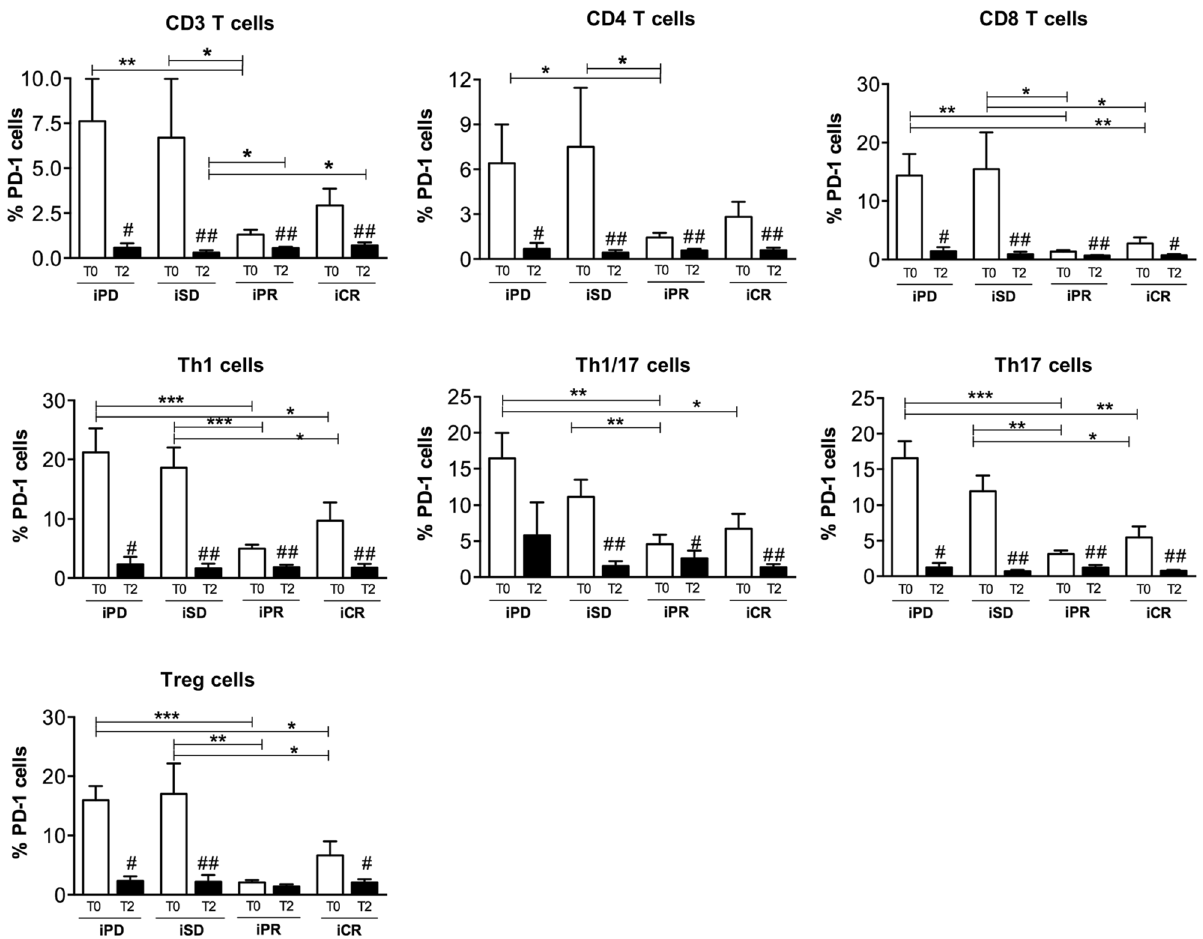
Figure 5. Expression of PD-1 in circulating T lymphocytes of melanoma patients treated with CPIs. Frequency of PD-1 positive cells gated within CD3, CD4, CD8, Th1, Th1/17, Th17, and Treg cells, was analyzed by flow cytometry in PBMCs of melanoma patients before (T0) and after 3 months (T2) of treatment. Best overall response according to iRECIST criteria: iPD, progressive disease (n. 7 patients); iSD, stable disease (n. 8 patients); iPR, partial response (n. 8 patients); complete response, iCR (n. 10 patients). Data are indicated as mean value ± standard error of the mean (SEM). * p < 0.05, ** p < 0.01, *** p < 0.001 as assessed by Mann–Whitney U test to compare between-group differences; # p < 0.05, ## p < 0.01 by Wilcoxon signed-rank test to evaluate before–after treatment